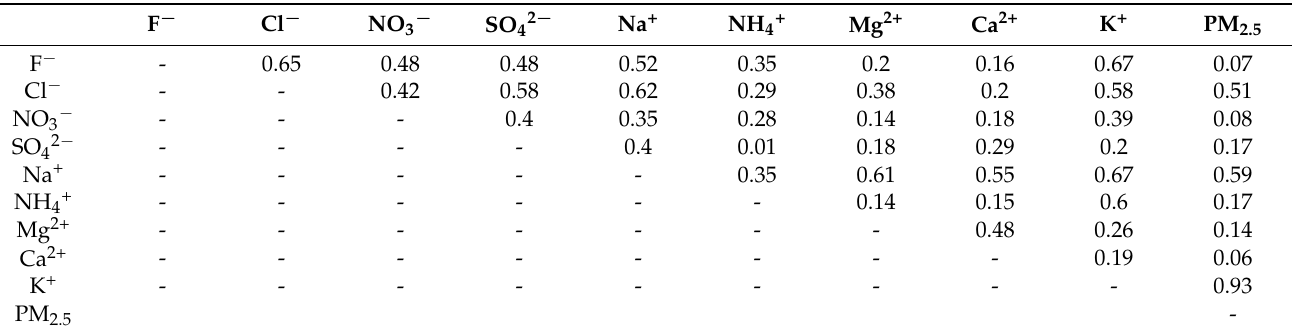
Figure 9 indicates a correlation of Cl − and Na + with the coefficient value of 0.62. No adjustments have been made to the outlying data. Outlying data at the bottom section had a low Cl − concentration, below 0.1 mg/L. These sample spots were extracted and compared with meteorological data sets. From Table 3, these low Cl − concentration cluster spots had an average RH of 91( ± 9)%, but 15 out of 23 points indicated 0 mm precipitation, and the rest of the 8 spots had 0.6 to 1.9 mm of precipitation. Additionally, those spots